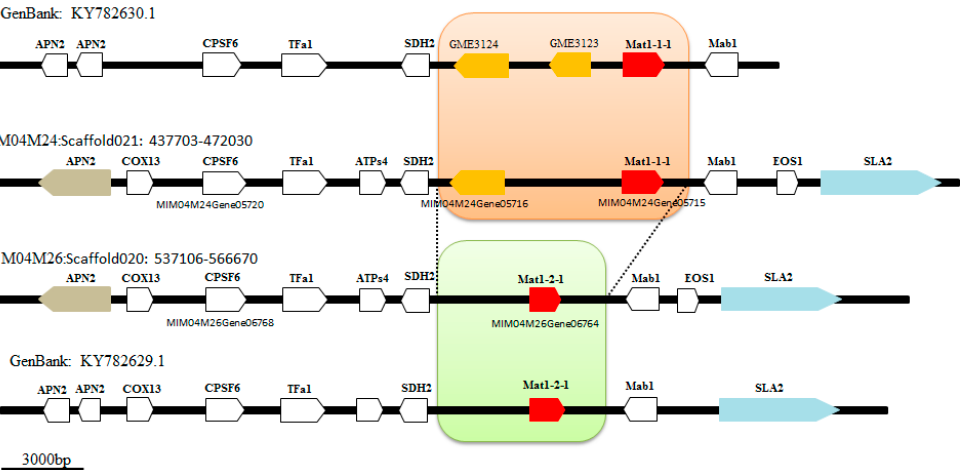
Figure 4. Structural analysis of two opposite-polarity monospore strains mating-type genes in Morchella importuna. The fine structure sketch was drawn manually based on the annotation information. M04M24 and M04M26 represent the mating loci of the two monospore strains used in this study. The sequences KY782629.1 and KY782630.1 reported in Chai et al. (2017) were downloaded from the National Center for Biotechnology Information (NCBI). The red box shows mating-type genes. The orange box represents the hypothetical gene. The flanking conserved genes are represented by SLA2 with a light-gray box and the APN2 gene with a pale blue purple. The sequence between the two dashed lines represents the largest different region of the two mating-type genes, with a sequence length of 6.6–11.9 kb. The ruler is 3000 bp.